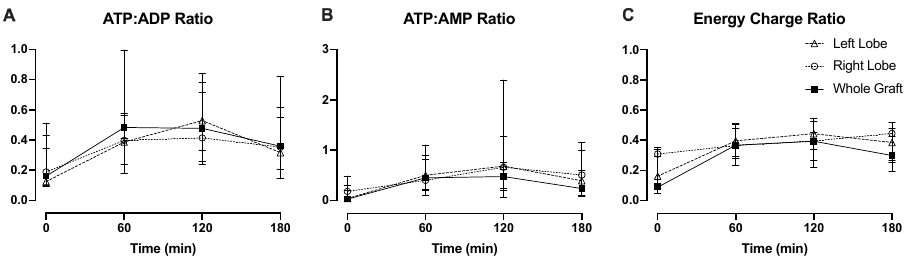
Figure 4. Energy status is reflective of metabolism during subnormothermic perfusion despite splitting. During whole- and split-liver perfusions, ( A ) ATP:ADP, ( B ) ATP: AMP, and ( C ) energy charge ratios demonstrated comparable patterns over time, indicating mitochondrial function and restoration of ATP stores.